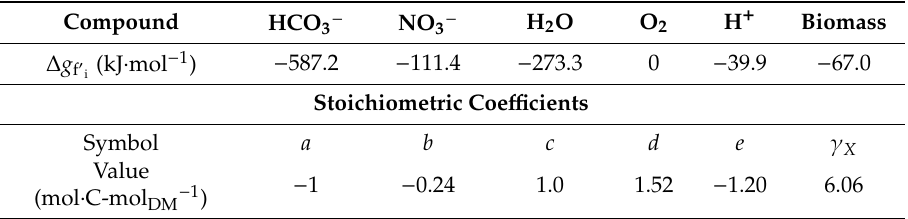
Table 4. Gibbs energies of formation under biological standard conditions of the compounds involved in the growth of Dunaliella tertiolecta biomass, and stoichiometric coe ffi cients estimated through material balances of carbon, nitrogen, oxygen, charge, and reduction degree of biomass ( γ X ). Compound HCO 3 − NO 3 − H 2 O O 2 H + Biomass ∆ g · mol − 1 ) − 587.2 − 111.4 − 273.3 − 67.0 f (cid:48) i (kJ Stoichiometric Coe ffi cients Symbol